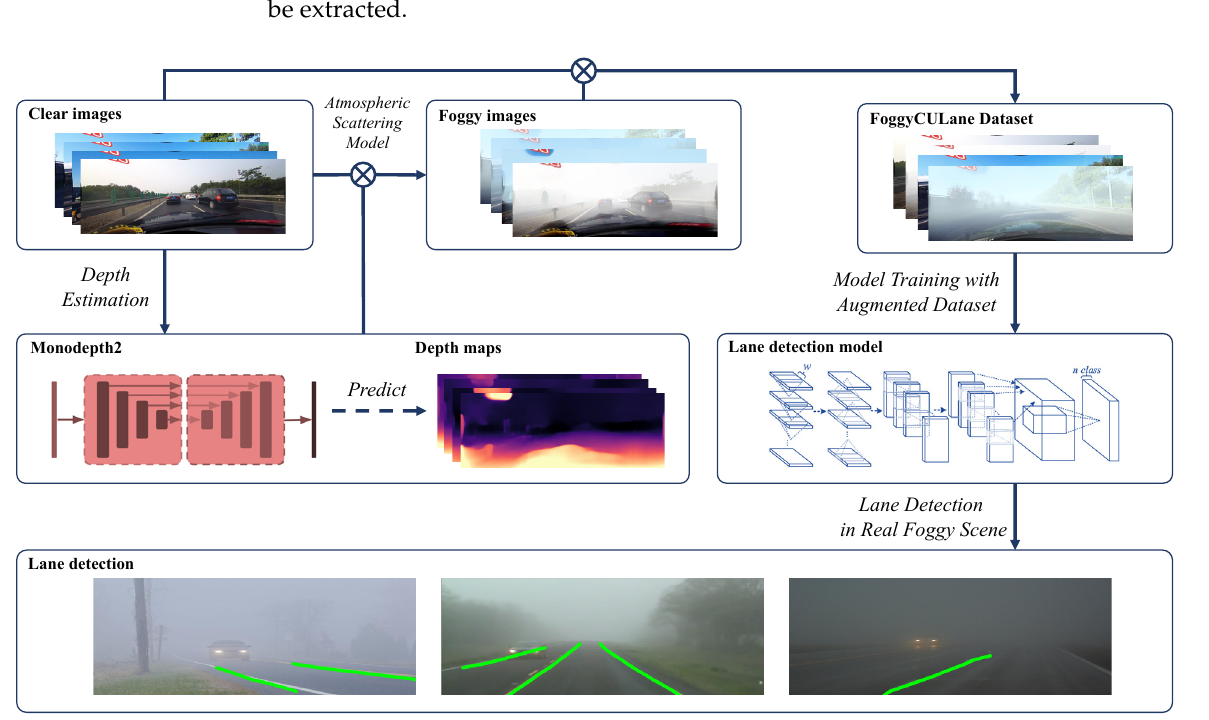
Figure 2. The pipeline to improve the performance of lane detection model in foggy scene with our method.